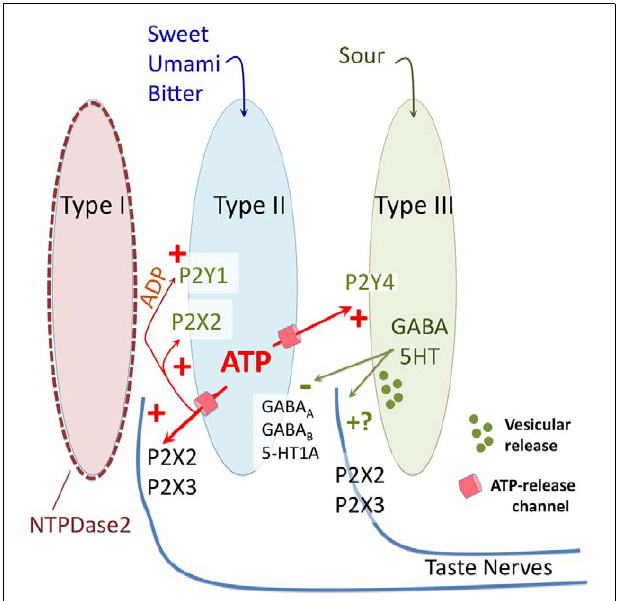
FIGURE 2 | Diagrammatic representation of purinergic signaling in taste buds. In response to bitter, sweet, and umami stimuli type II taste cells release ATP via non-vesicular release channels.The released ATP activates afferent nerve fibers by binding to ionotropic receptors containing P2X2 and P2X3 subunits.The released ATP is hydrolyzed to ADP by a specific ectoATPase, NTPDase2, expressed on the membranes of type I taste cells. In addition to activation of afferent nerves, the released ATP (and its breakdown product ADP) activate purinergic receptors (P2X2 and P2Y1) on the type II cells themselves to potentiate further ATP release. ATP also activates the sour-sensitive type III taste cells via P2Y4, causing vesicular release of 5HT and possibly GABA, which in turn inhibits further ATP release from the type II taste cells via a paracrine feedback mechanism. Unclear is whether the 5HT and GABA also activate the afferent nerve fibers, and what the source of ATP is for sour taste, since all taste qualities require ATP for activation of afferent